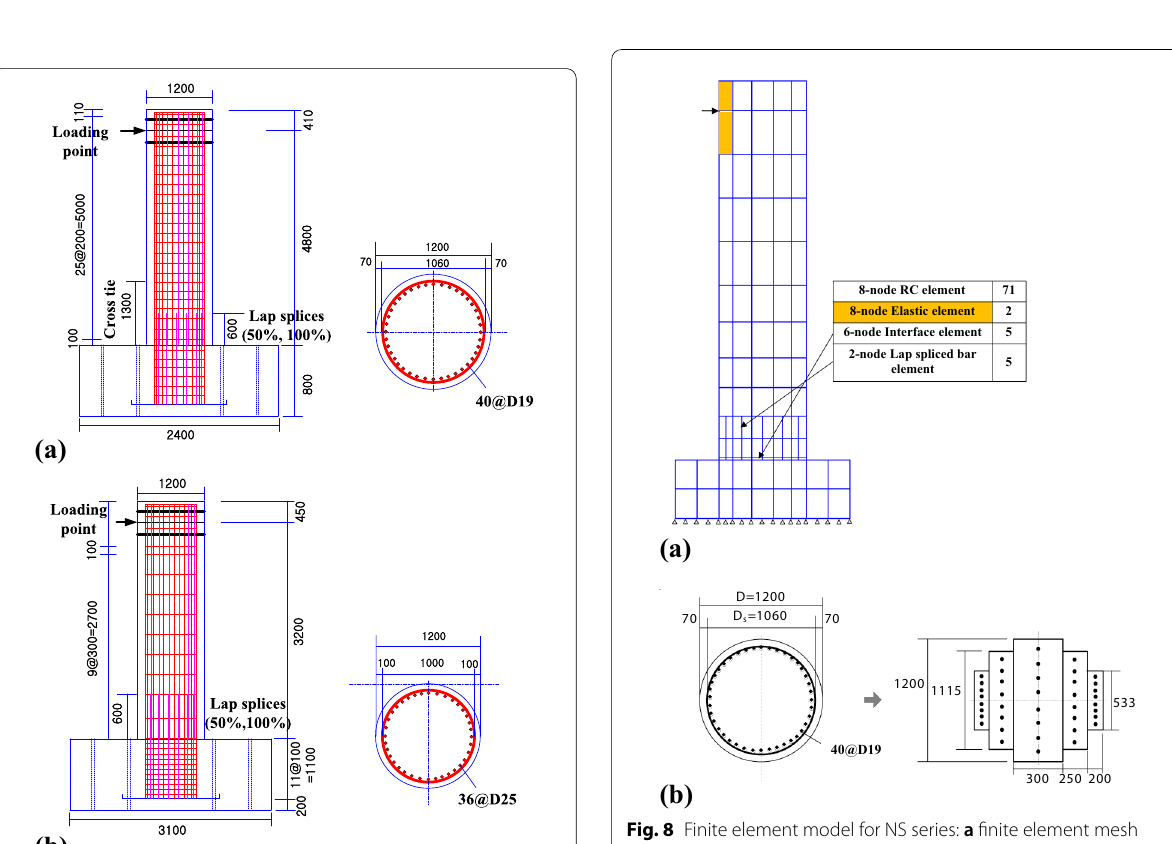
Fig. 8 Finite element model for NS series: a finite element mesh and b transformation of a circular column to an idealized equivalent rectangular column (Unit: